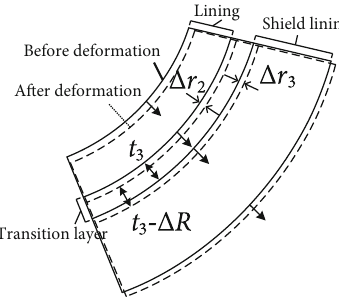
Figure 2: Radial displacement of lining